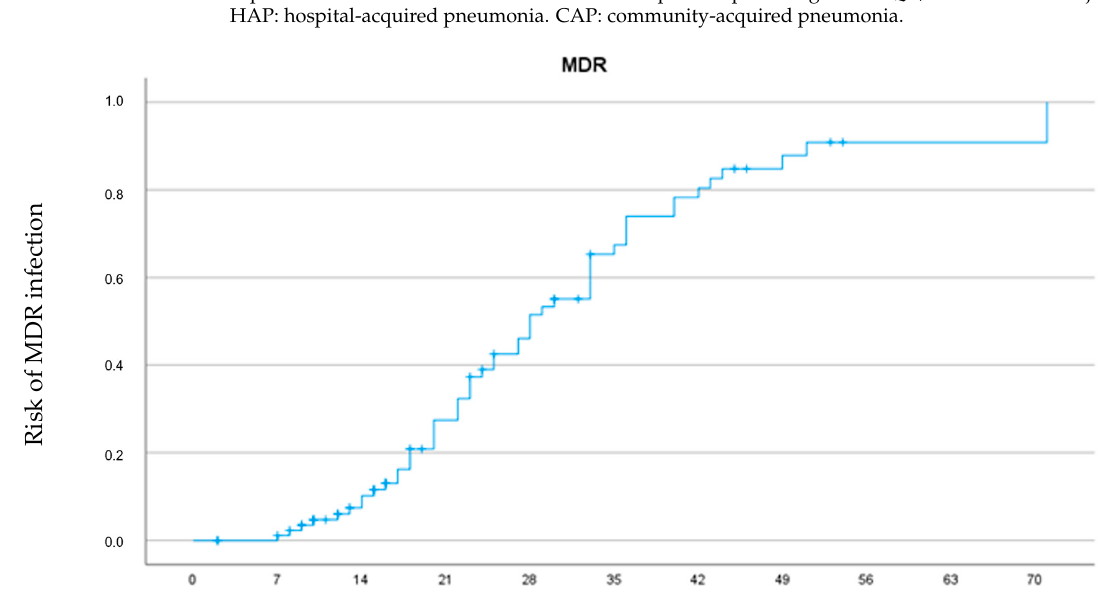
Figure 1. Relationship between length of stay and risk of MDR infection.